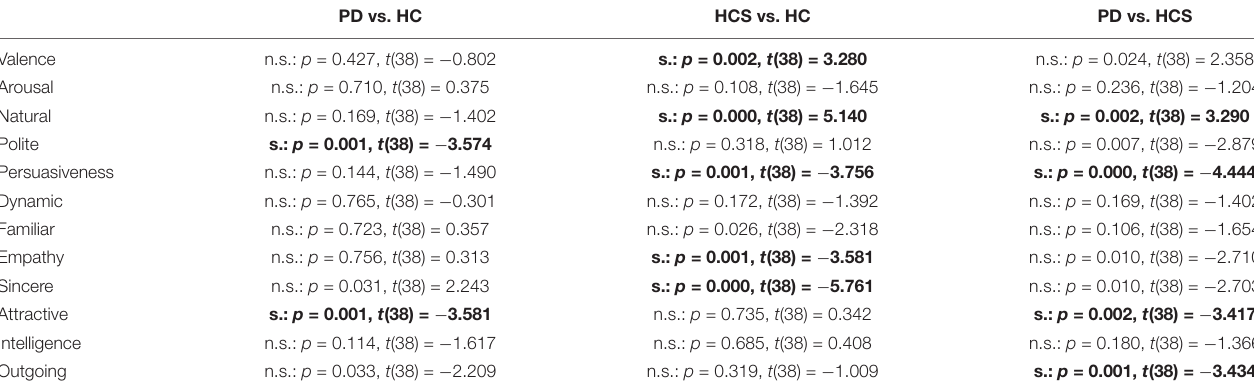
TABLE 3 | Results of the statistical tests comparing ratings for negative expressions only across dimensions and different participant groups. PD vs. HC HCS vs. HC PD vs.